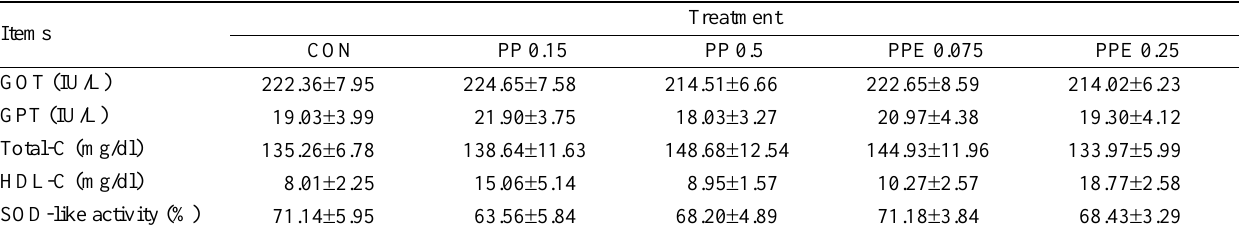
Table 5. Effects of persimmon peel (PP) and persimmon peel ethanol extract (PPE) on blood parameters and SOD activity in laying hens